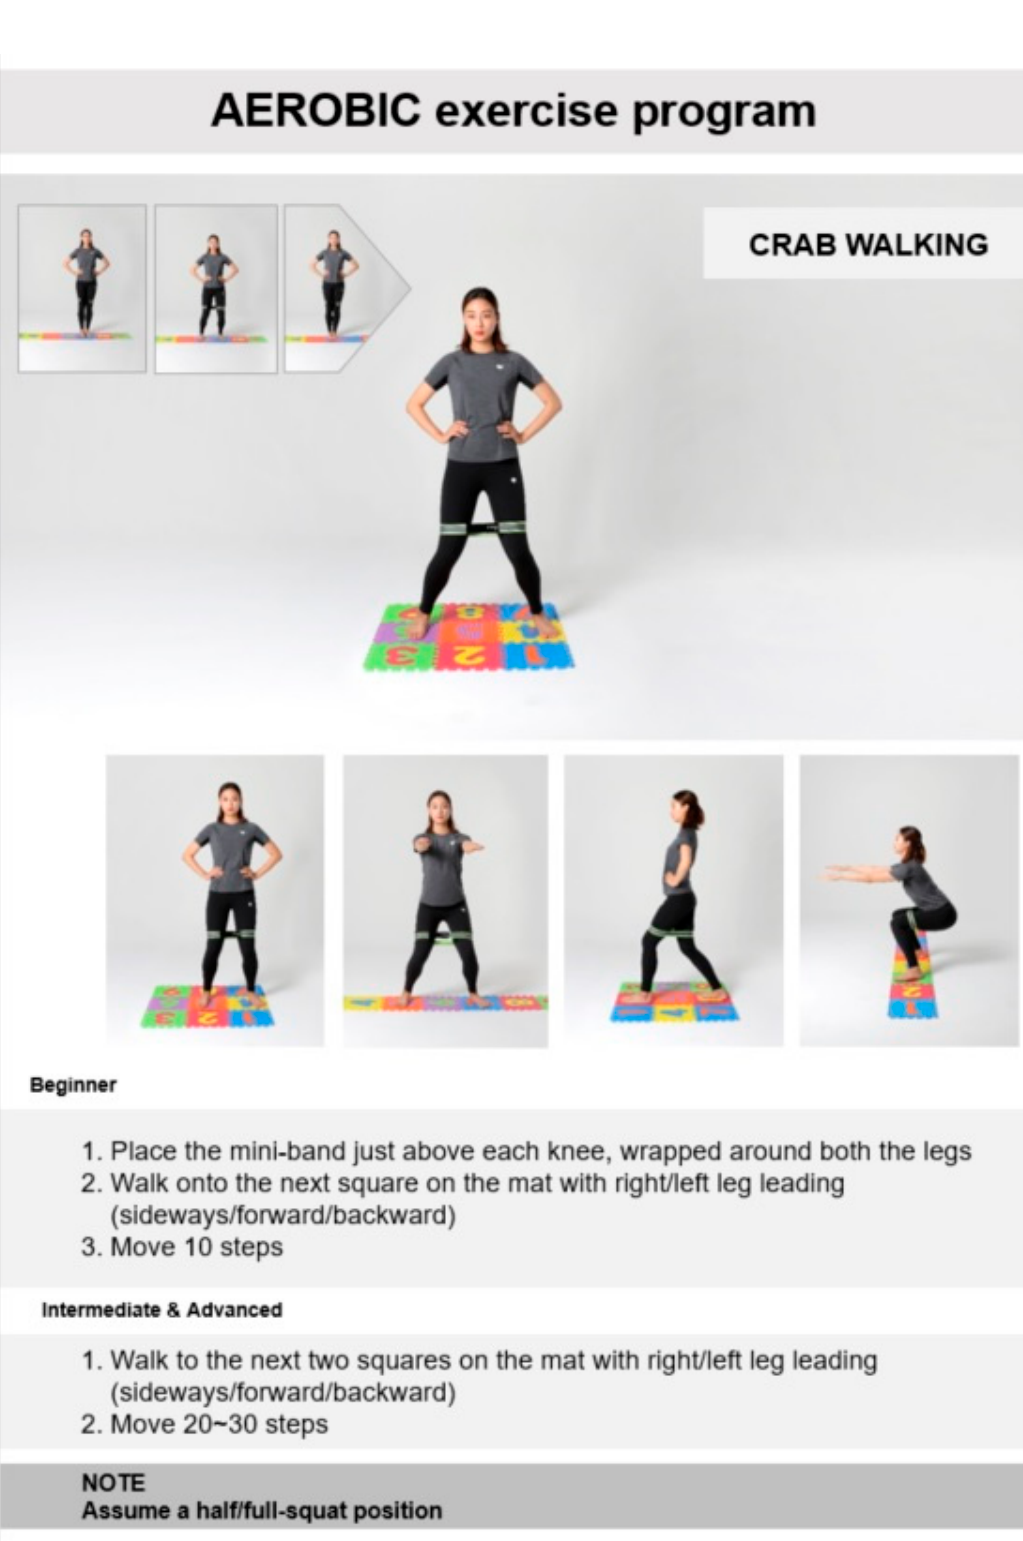
Figure A9. Detailed description and components of each movement in the “Crab walking” aerobic exercise.